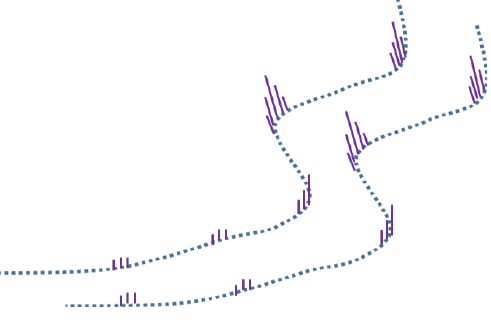
Figure 8. Roadway feature points.